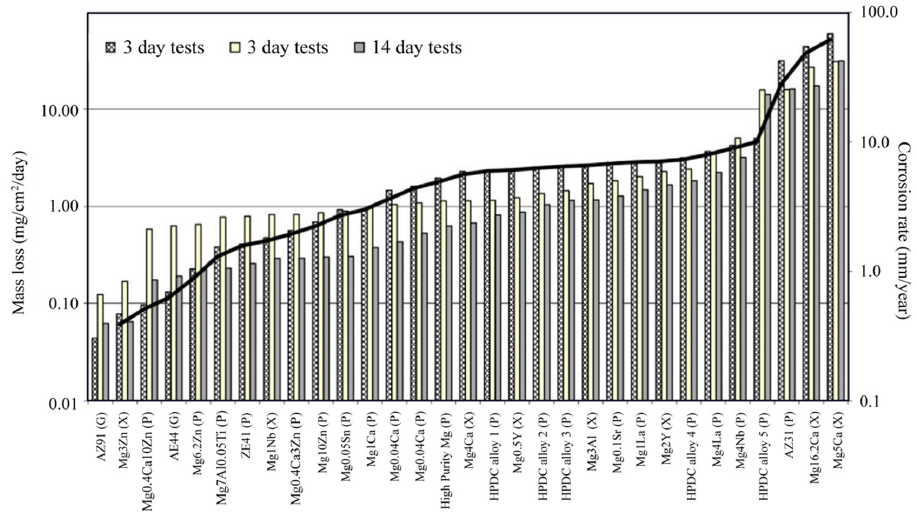
Figure 6. Experimentally determined degradation rates, which differ from Mg-based alloy composition at 37 °C in MEM [238].